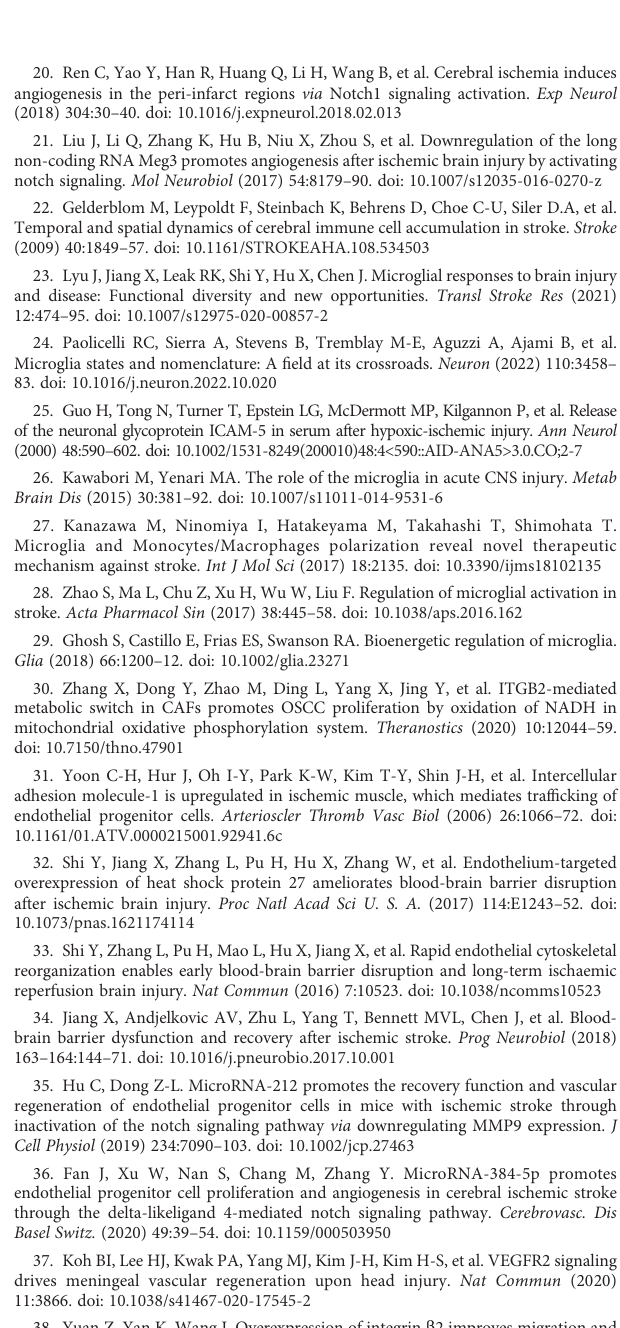
SUPPLEMENTARY FIGURE 4 Conventional scRNA-seq analysis of microglia. (A) Bubble map of functional enrichment analysis of microglia subclusters. Colors represent signi fi cant differences(p ≤ 0.05). (B) Heatmap of top 5 genes for microglia subcluster by the conventional